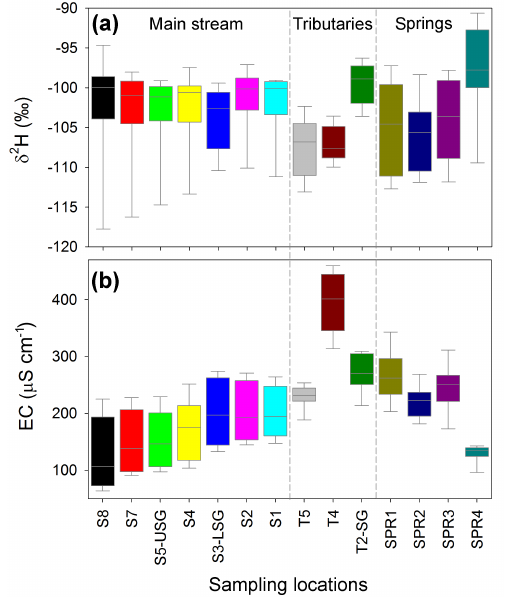
Figure 2. Box plot of δ 2 H (a) and EC (b) for samples taken on the same day at all locations in 2011 and 2012 ( n = 10 for all locations except for isotope data in T5 and for both tracers at SPR1, for which n = 9). Locations T1 and T3 are excluded because sampled only for 1 year. The boxes indicate the 25th and 75th percentile, the whiskers indicate the 10th and 90th percentile, the horizontal line within the box defines the median. In 2013, samples were collected only at some locations (Table 1) and therefore, for consistency, 2013 data are not reported